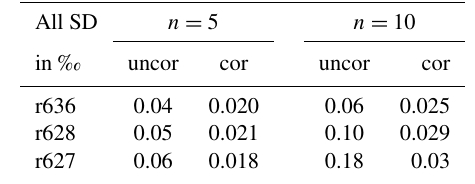
Table 1. Relative standard deviations for n = 5 and n = 10 of un- corrected (uncor) and corrected (cor) isotope ratio sample measure- ments. Sample measurements were always bracketed by measure- ments of the working gas. Standard deviations of the uncorrected measurements only use the sample measurements; standard devia- tions of the corrected measurements use drift-corrected (Eq. 1) sam- ple measurements using the working gas